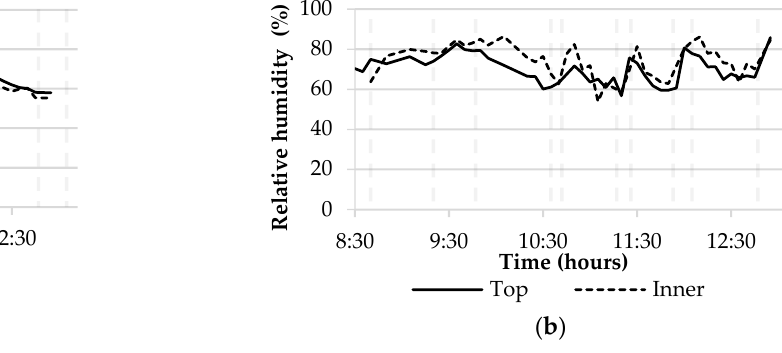
Figure 11. Average of top and inner sensor readings for temperature ( a ) and relative humidity ( b ).